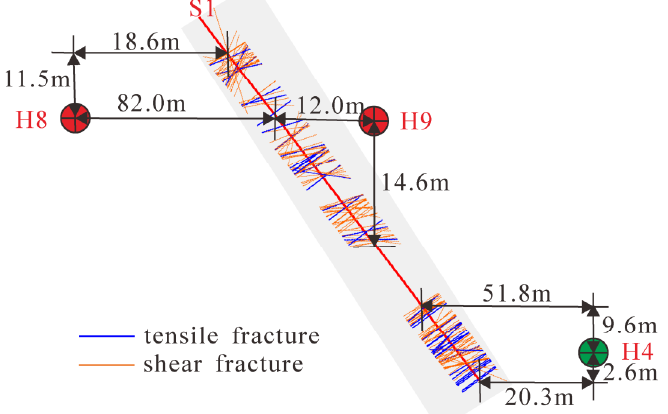
Figure 11. Diagram of hydraulic fractures along the coring trajectory with respect to the adjacent horizontal wells.